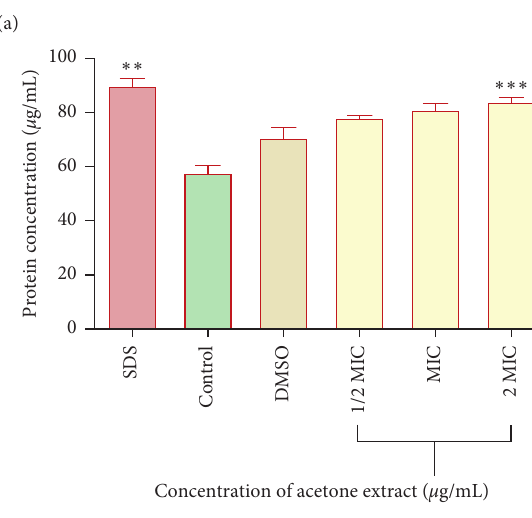
Figure 1: Effect of leaf extracts from P. americana on protein leakage from S . epidermidis cells at 1/2 MIC, MIC, and 2 MIC. (a) Water: ethanol extract, (b) DCM:water extract, and (c) acetone extract. The values shown are for mean ± standard deviation for n � 3. Untreated cells were the negative control and SDS (sodium dodecyl sulphate) was the positive control. The asterisks indicate a significant difference from the control with ∗∗ p < 0 . 01 and ∗∗∗ p < 0 .